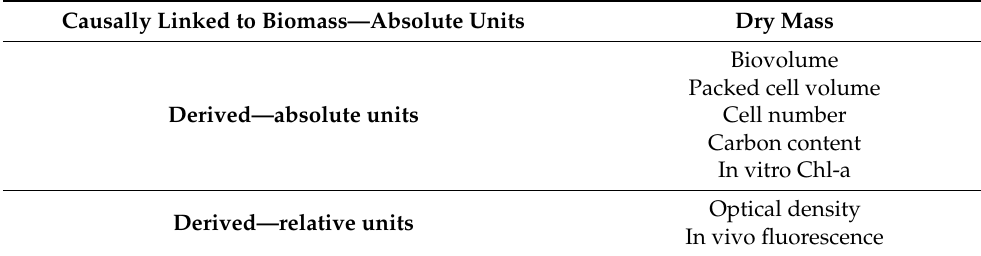
Table 1. Comparison of parameters for algal biomass estimation. Causally Linked to Biomass — Absolute Units